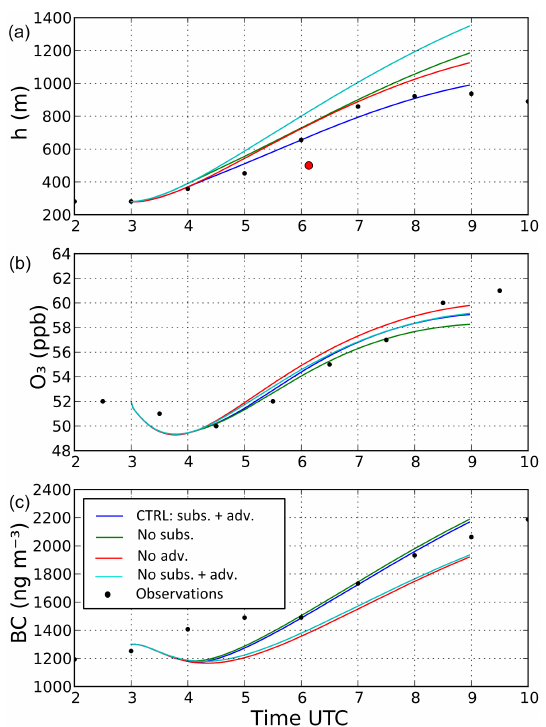
Figure 9. Diurnal variations in MXL/MESSy simulated (a) bound- ary layer height, (b) surface ozone, and (c) Black Carbon (BC) on 15 March 2012 for four different simulations. The CTRL simula- tion includes both subsidence and advection of cool and moist air. In the no subs. simulation subsidence is turned off, in the no adv. simulation advection is turned off, and in the no subs. + adv. simu- lation both subsidence and advection are turned off. In each panel, the black dots show observations made at the surface. In addition, the red dot in the upper panel shows the boundary layer height from a radiosonde